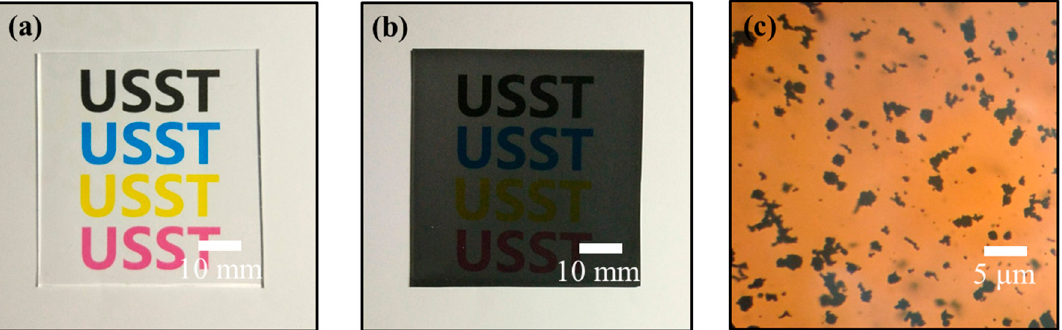
Figure 1. ( a ) Sample of pure polydimethylsiloxane (PDMS) (thickness h 0 = 1 mm), placed on top of paper with printed colored fonts. ( b ) Sample of the dyed PDMS (thickness h 0 = 1 mm), placed in the same position as that of the sample in (a). ( c ) Formation of the composite film observed under an optical microscope.